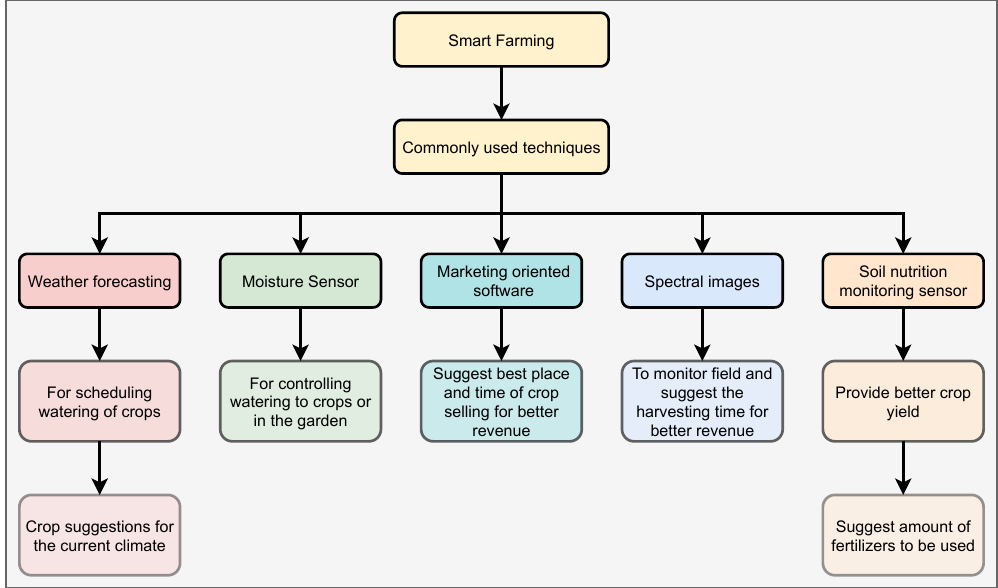
Figure 4. Smart farming technologies and their